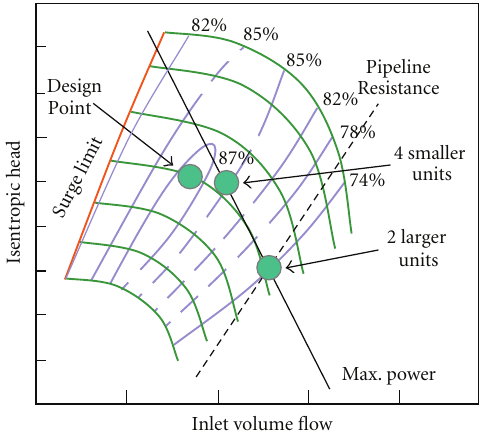
Figure 10: Impact of loss of one unit for the 4 unit and the 2 unit